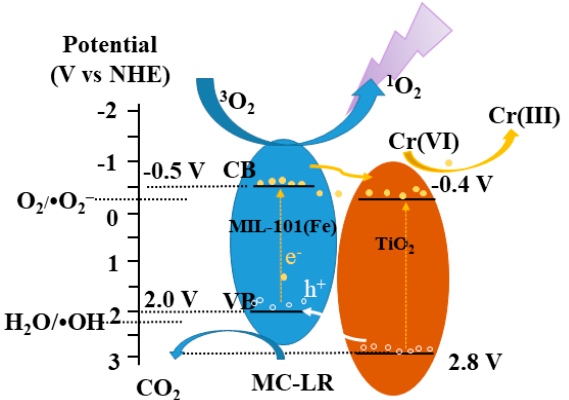
Figure 9. Schematic mechanism of simultaneous Cr(VI) reduction and MC-LR oxidation over 0.1 M/P under UV light irradiation.